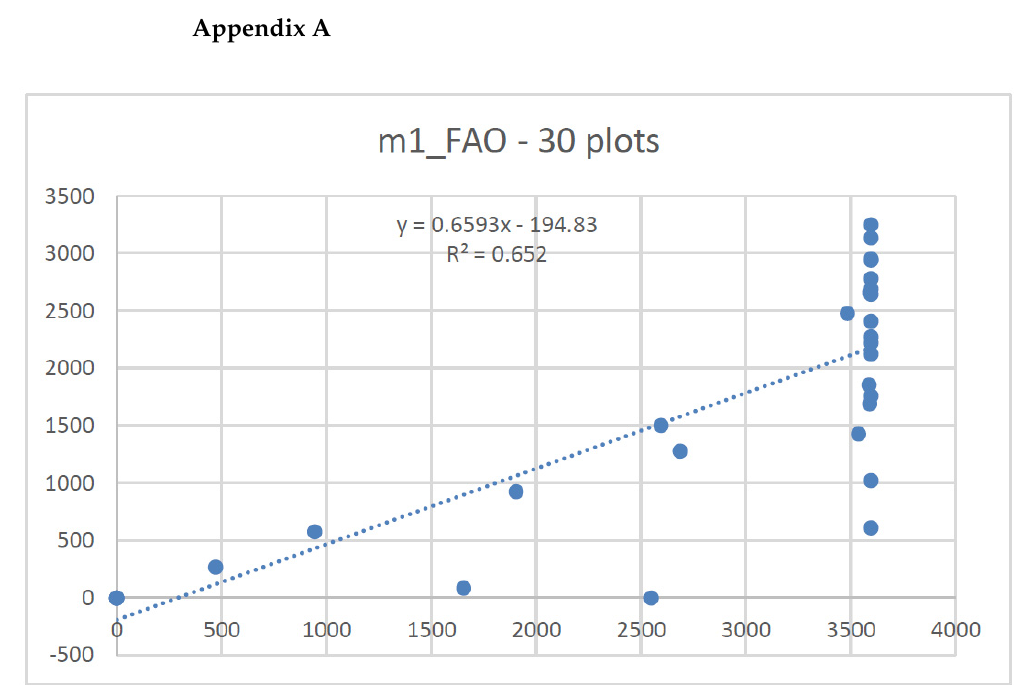
Figure A1. The reference area compared to the estimated forest area according to Method 1 for test plots (30 × 30 m 2 ) as defined by FAO/UN.